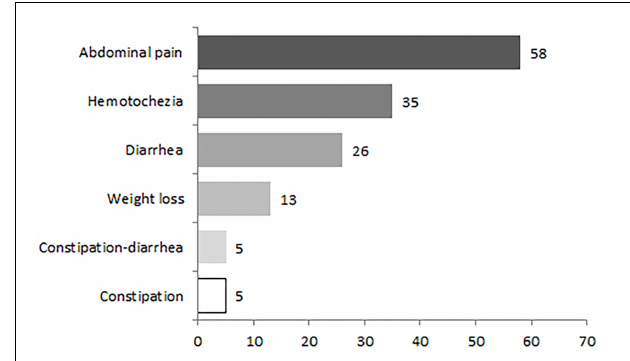
FIGURE 2 | Common clinical symptoms in 70 patients with idiopathic myointimal hyperplasia of the mesenteric veins